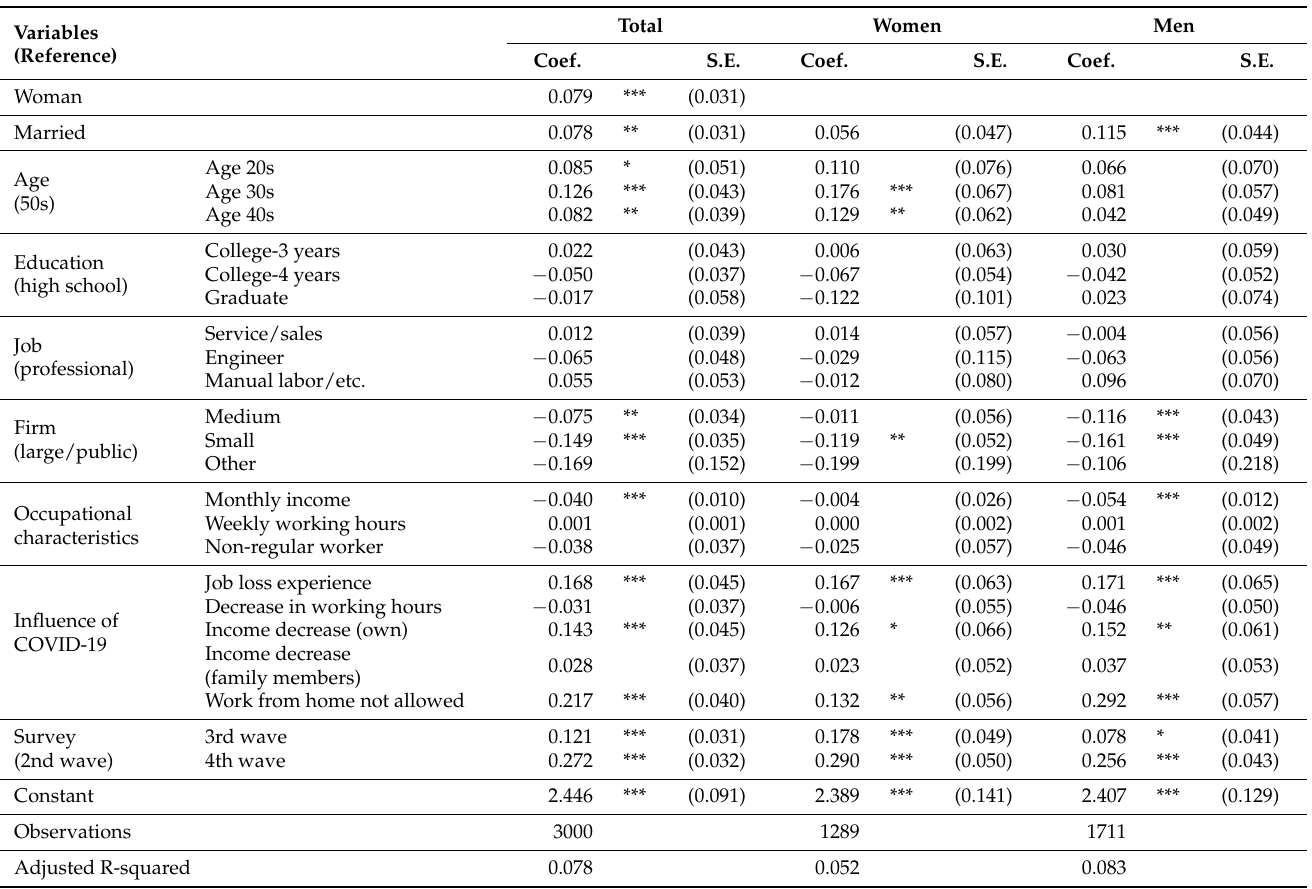
Table A1. Results of OLS regressions for anxiety.